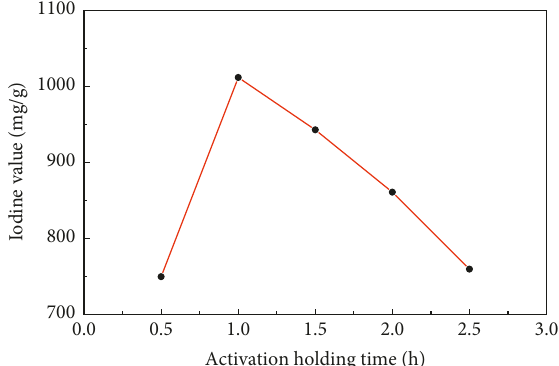
Figure 3: The influence of the activation holding time on the iodine value of sludge